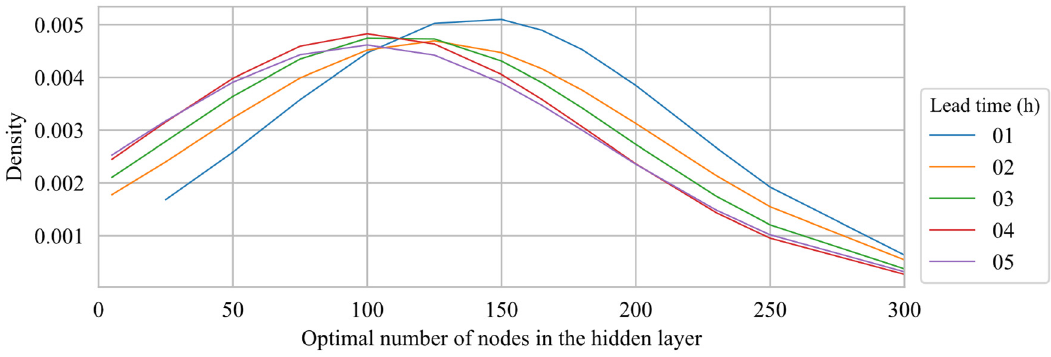
Figure 5. Distribution of the number of nodes in the hidden layer of the ELM model selected as optimal for the different lead times.